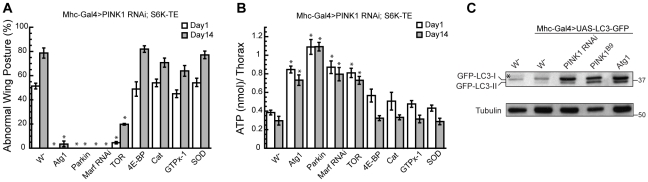
Atg1 OE rescues PINK1 RNAi phenotype by inducing autophagy.(A, B) The rescuing effect of Atg1 OE in PINK1 RNAi flies was not dependent on S6K inhibition. Atg1 OE, as well as Parkin OE or Marf RNAi, efficiently rescued the abnormal wing posture (A) and muscle energy depletion (B) in PINK1 RNAi/S6K-TE flies. In contrast, overexpression of 4E-BP and the antioxidant genes were not as effective. Data are presented as mean ± s.e.m. Statistical significance was determined by Student's t test (*P<0.001). (C) Overexpression of Atg1 was sufficient to induce autophagy in fly muscle. UAS-LC3-GFP was expressed in the muscle of flies with the indicated genetic background, and the level of autophagy was determined by Western Blot using anti-GFP antibody. Overexpression of Atg1 significantly increased the level of LC3-II in the muscle, indicating increased autophagy. Increased autophagy was also observed in PINK1 RNAi and PINK1 mutant flies. (* indicates a cross-reaction band).